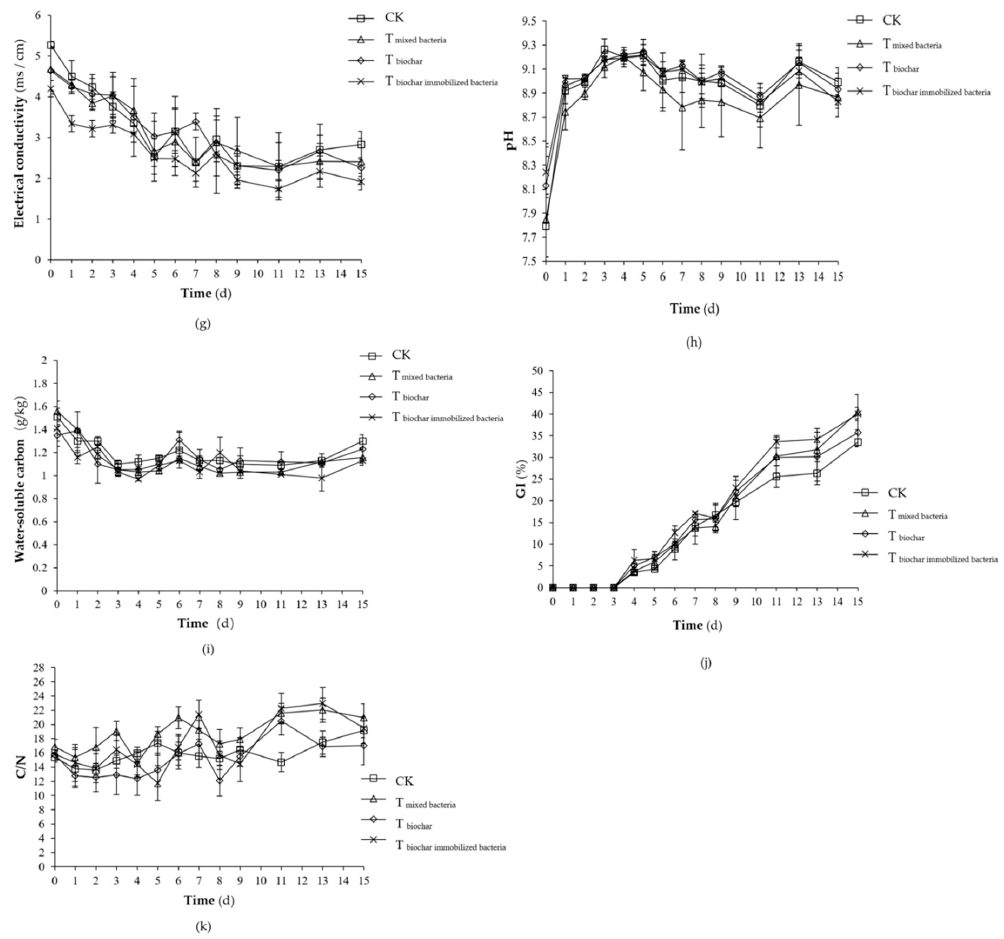
Figure 3. Evaluation of the total nitrogen ( a ), NH 4+ -N ( b ), NO 3 -N ( c ), temperature ( d ), moisture content ( e ), organic matter ( f ), electrical conductivity ( g ), pH ( h ), water-soluble carbon ( i ), seed germination rate ( j ), and C/N ( k ) profile of different treatments during composting (CK: as the control); Note: Values are based on wet weight and error bars represent the standard deviation ( n = 3).